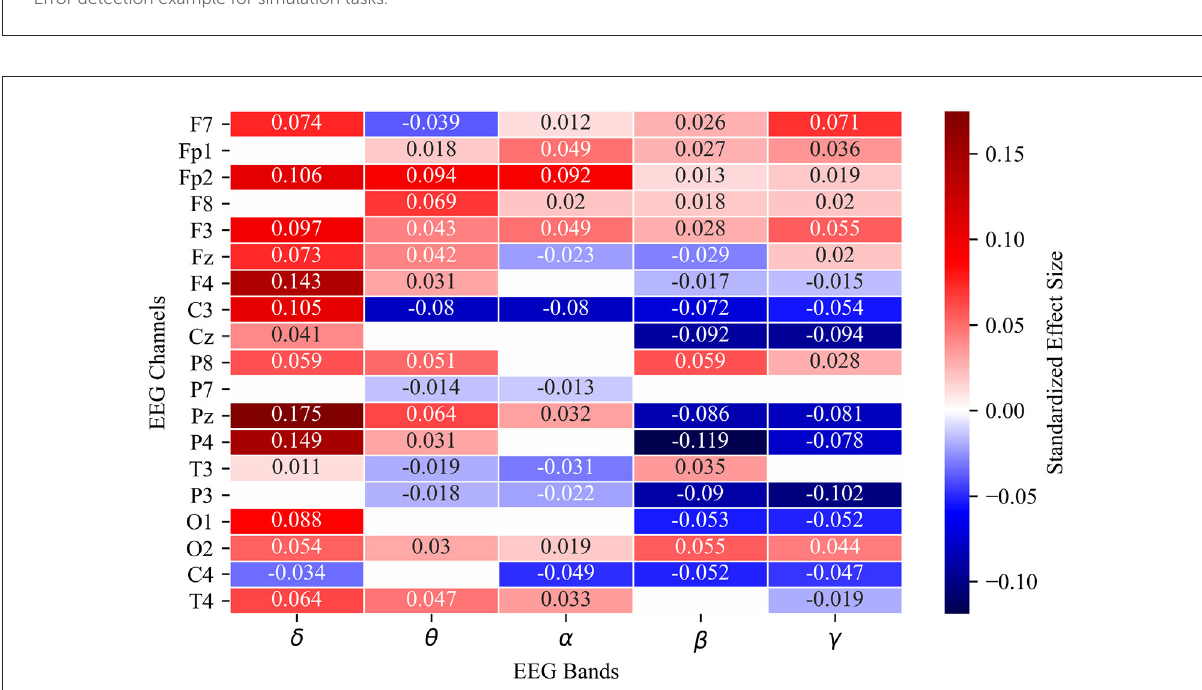
FIGURE4 Heat map of estimated fixed effects for 95 linear mixed effects models representing all channel-band combinations of 19 EEG channels and 5 spectral power bands. Fixed effect estimate labeled numerically and by color intensity in each cell. Only significant channel-band combinations are included in heat map. Blank cells did not meet corrected significance threshold of P =